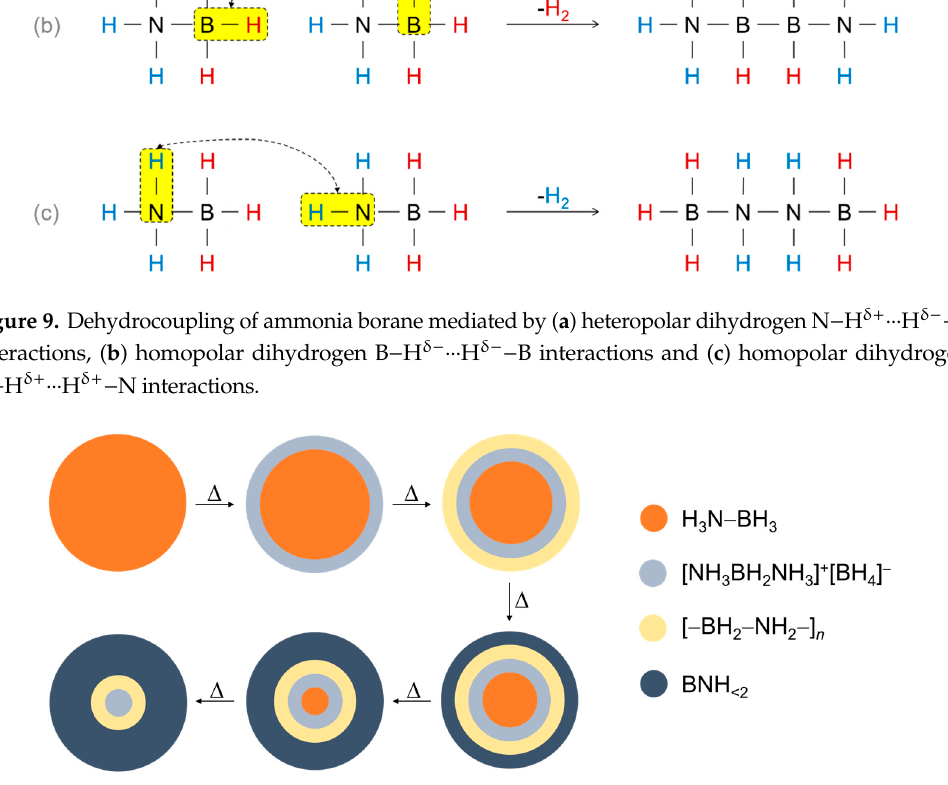
Figure 10. Illustration of the heterogenous decomposition of ammonia borane: all of the molecules would not simultaneously decompose and polymerize.